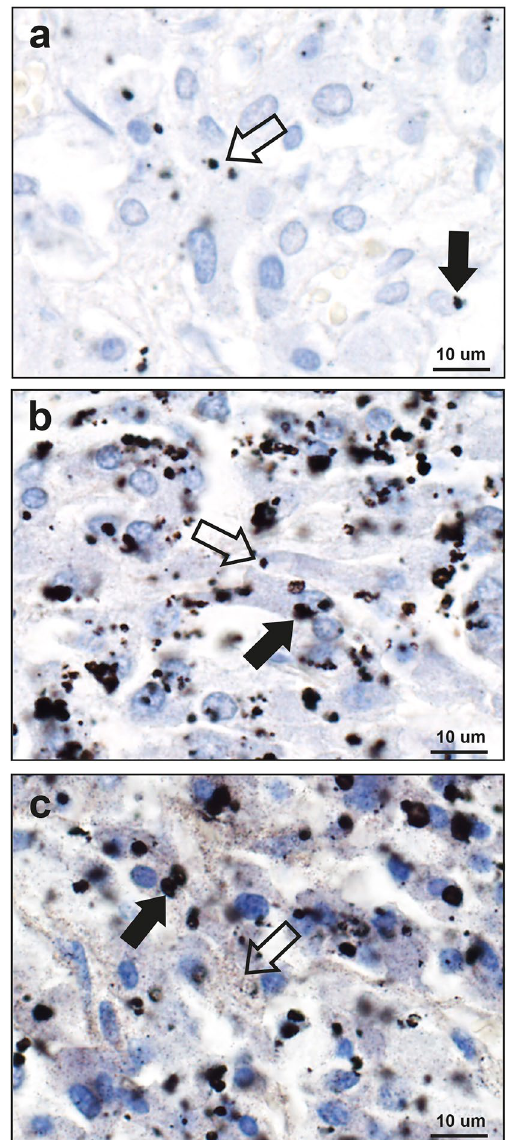
Figure 3. Patterns of AMG staining in the adrenal medulla. ( a ) Small dense black AMG granules, either adjacent to nuclei (filled arrow) or within the cytoplasm (open arrow), are present in fewer than 25% of these chromaffin cells (69 year-old male). ( b ) Black AMG granules, either large (filled arrow) or small (open arrow), often multiple, are present in the cytoplasm of more than 25% of chromaffin cells (32 year-old male). ( c ) Black AMG staining is present in most chromaffin cells, either as small grains dispersed in the cytoplasm (open arrow), or as these small grains accompanied by dense granules (filled arrow) (39 year-old male). AMG and